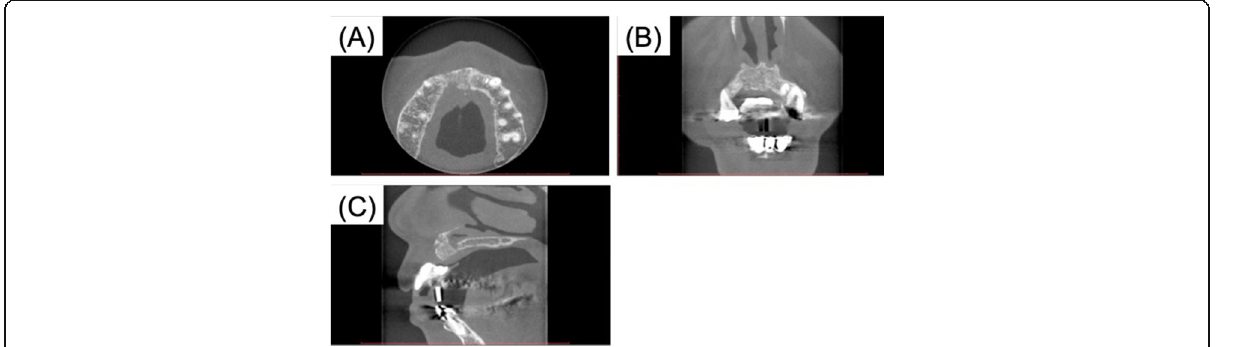
Fig. 5 Cone-beam CT findings after removal of the mesh. a Axial. b Coronal. c Sagittal